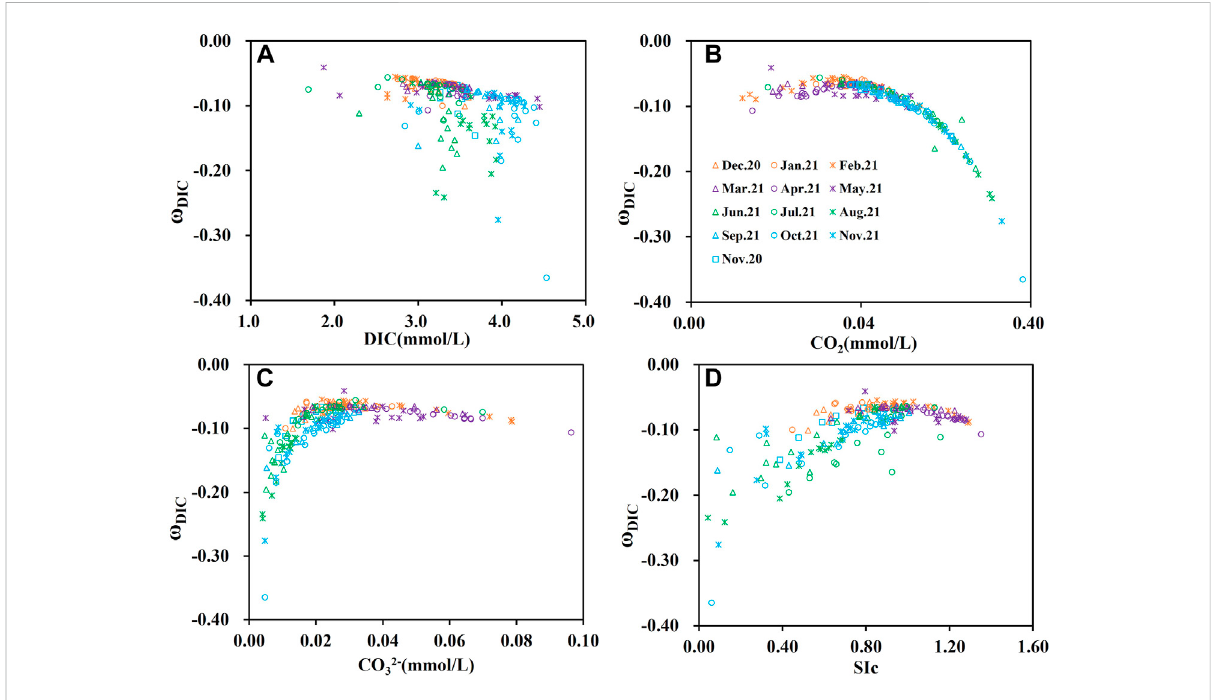
FIGURE 6 (A) Correlation between ω DIC and DIC concentration; (B) Correlation between ω DIC and CO 2 ; (C) Correlation between ω DIC and CO 3 2 − ; (D) Correlation between ω DIC and calcite saturation (SIc) in the Huatan River